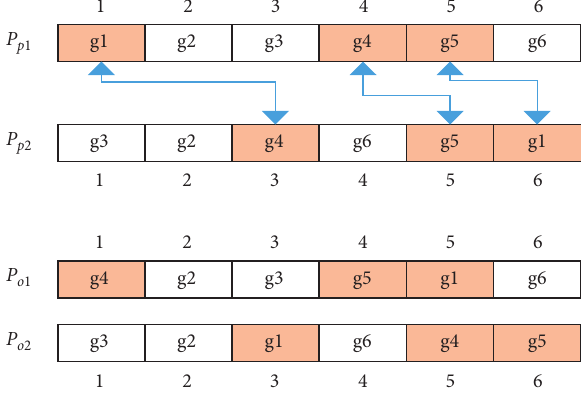
Figure 2: Schematic diagram of sequence-based